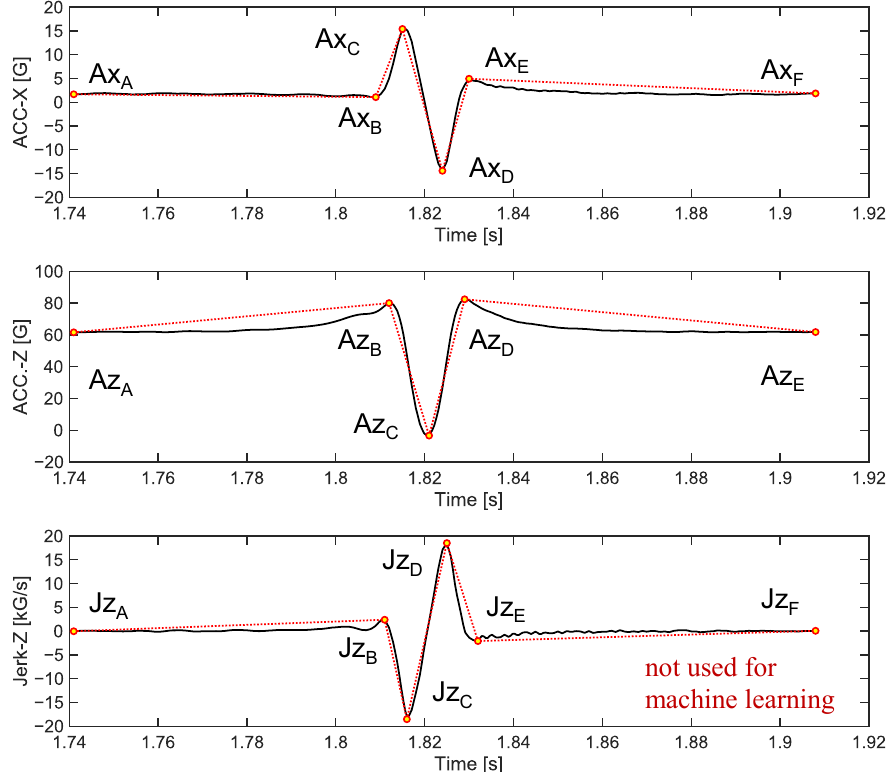
Figure 7. Points that were manually chosen to capture the characteristics of the acceleration signals.